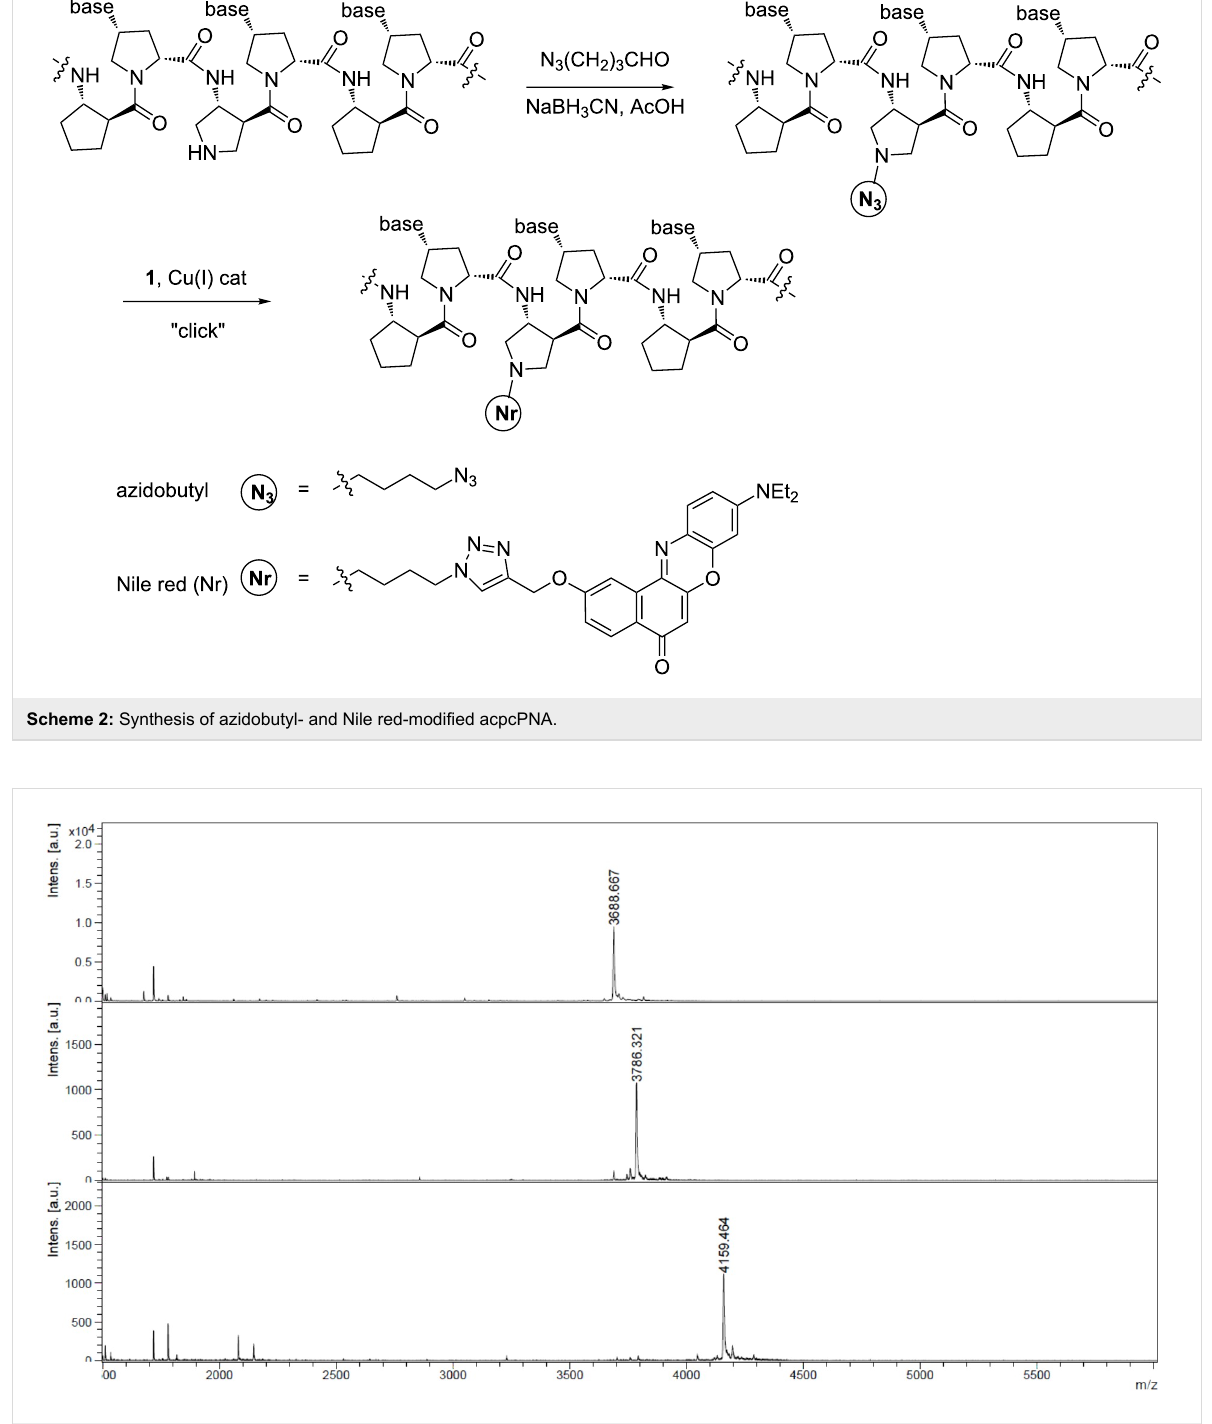
651 nm; Φ F 0.14). In aqueous phosphate buffer (10 mM, pH 7.0), the Nile red-labeled acpcPNA 10mer-Nr exhibited a broad absorption peak centered at 575 nm and a fluorescence